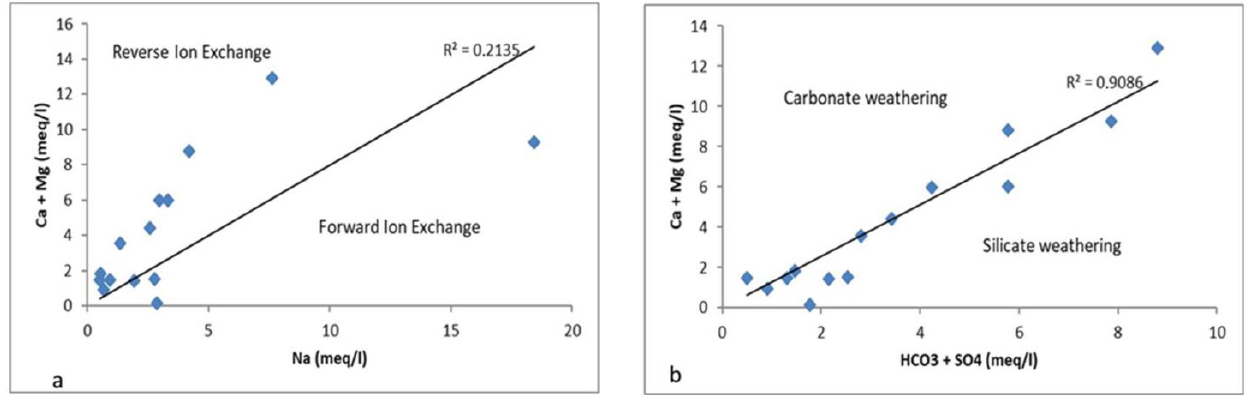
Figure 6. Scatter plots for ( a ) Ca 2+ + Mg 2+ /Na + and ( b ) Ca 2+ + Mg 2+ /HCO 3 − + SO 4 − of water collected in the Soutpansberg region.